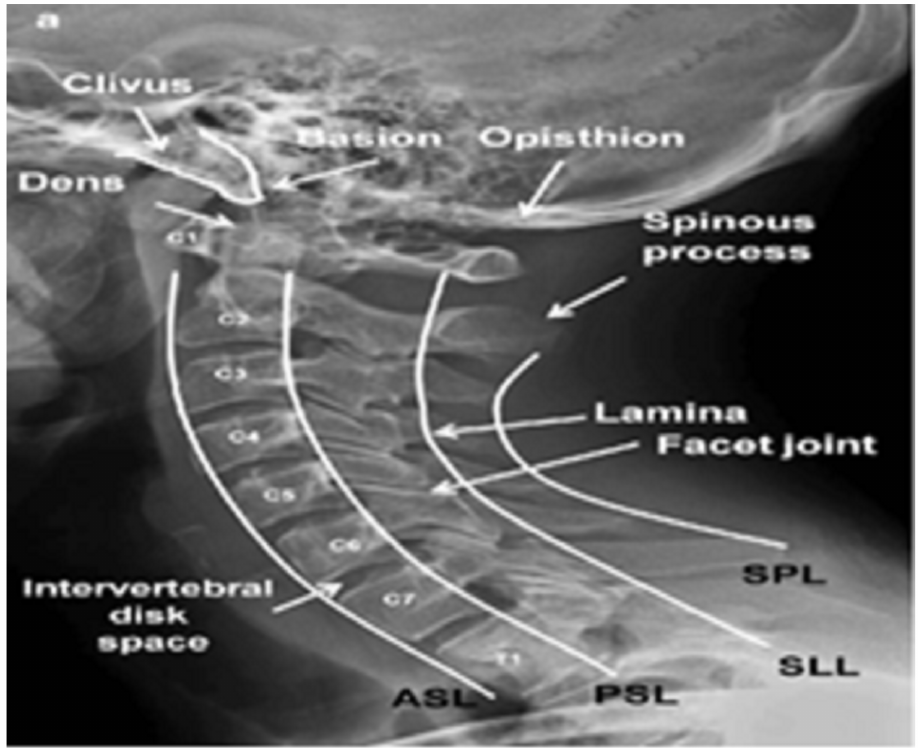
Figure 1. Lateral view of the CS